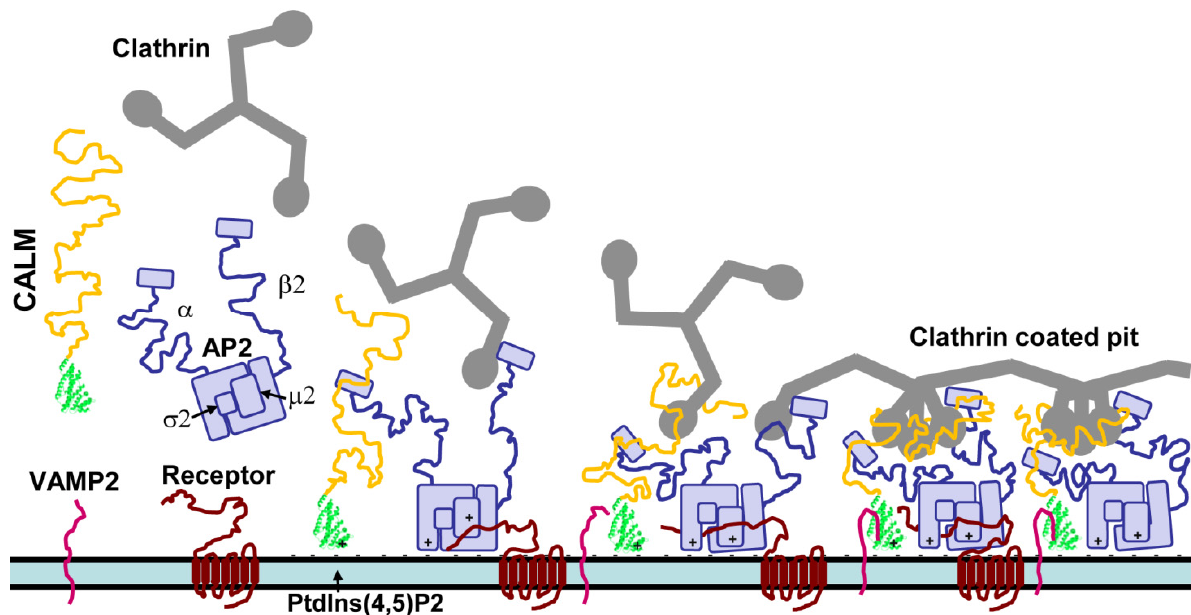
Figure 1. The interactions of CALM during the early stages of